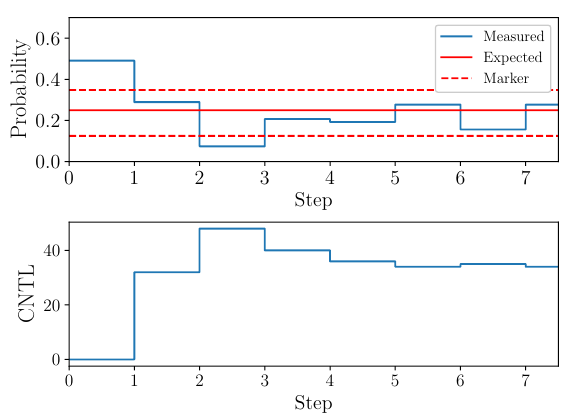
Figure 6: LPPN processor calibration: error probability (top) and control signal